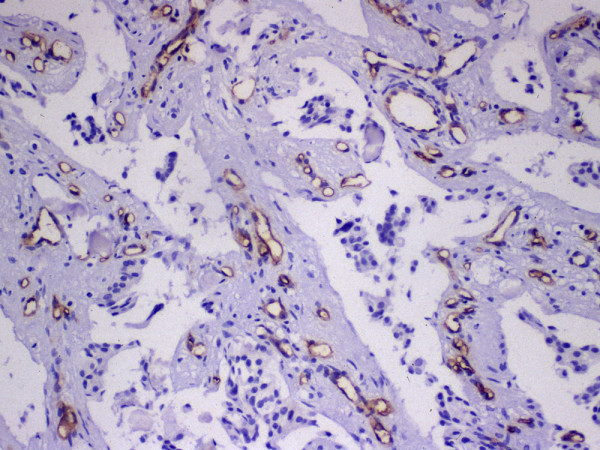
Highest microvessel count – VEGF. After scanning at low power (40×), three areas with the highest concentration of microvessels (vascular hot spots) were selected. Each area was evaluated with one high power (200×) field in such a way as to include the maximum number of microvessels. The highest value obtained among the three fields was reported as HMC.